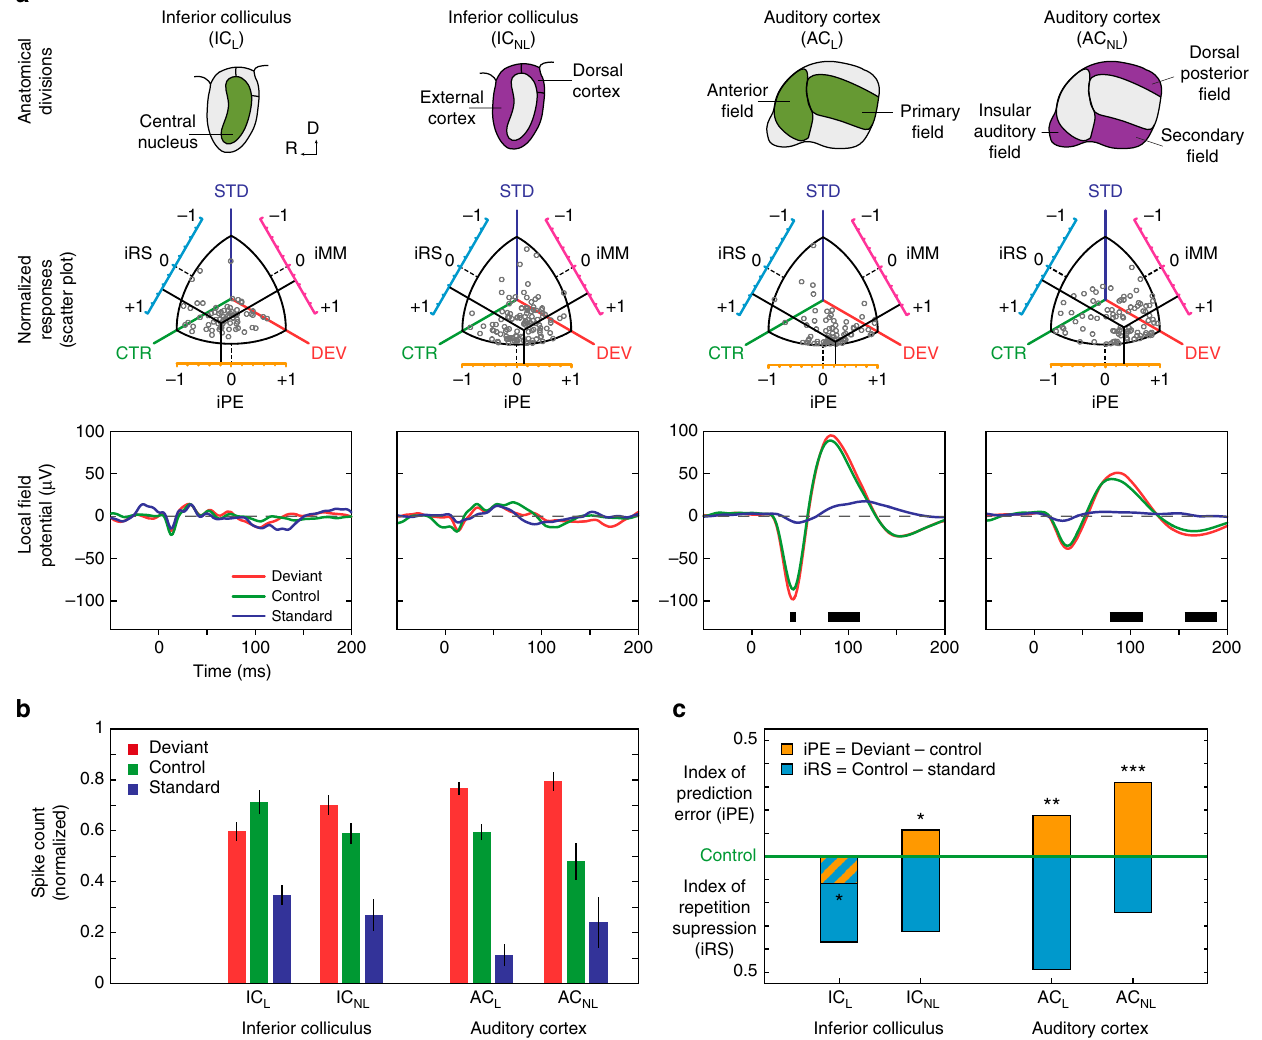
Fig. 7 Population results for awake mouse. a Summary of population results for each recorded station (columns). The fi rst row displays lemniscal (green) and non-lemniscal (purple) subdivisions of two recorded auditory nuclei of the mouse brain. The second row contains scatter plots featuring normalized responses of each multiunit recording to the same tone played as DEV, STD and CTR (grey dots) and the mean population values of each index (solid black bars). The third row contains the average LFP across all tested tones from each station for different conditions. Thick black bars at the bottom of the panels mark the time intervals were the difference between the deviant LFP and the control LFP is signi fi cant, thereby producing a prediction error potential. b Median normalized responses (bar indicate interquartile range) to the deviant, standard and control within each station. c Median indices of prediction error (orange) and repetition suppression (cyan), represented with respect to the baseline set by the control. Asterisks denote statistical signi fi cance of